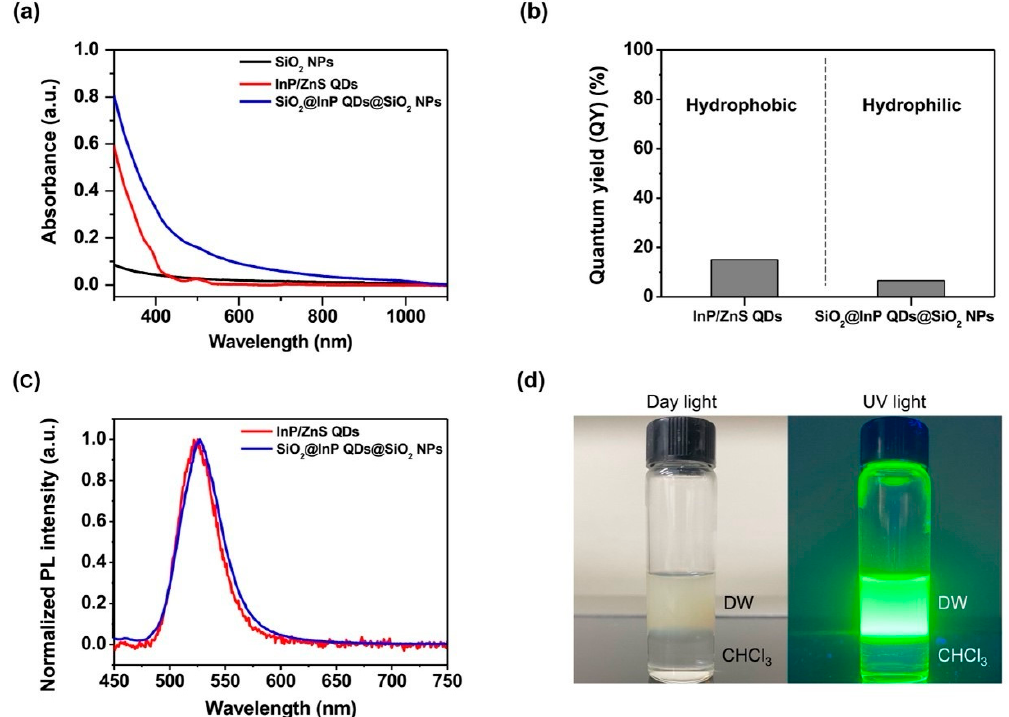
Figure 2. Characterization of SiO 2 @InP QDs@SiO 2 NPs. ( a ) UV/Vis/NIR absorbance spectra of SiO 2 NPs, InP/ZnS QDs, and SiO 2 @InP QDs@SiO 2 NPs. ( b ) Comparison of quantum yield (QY)